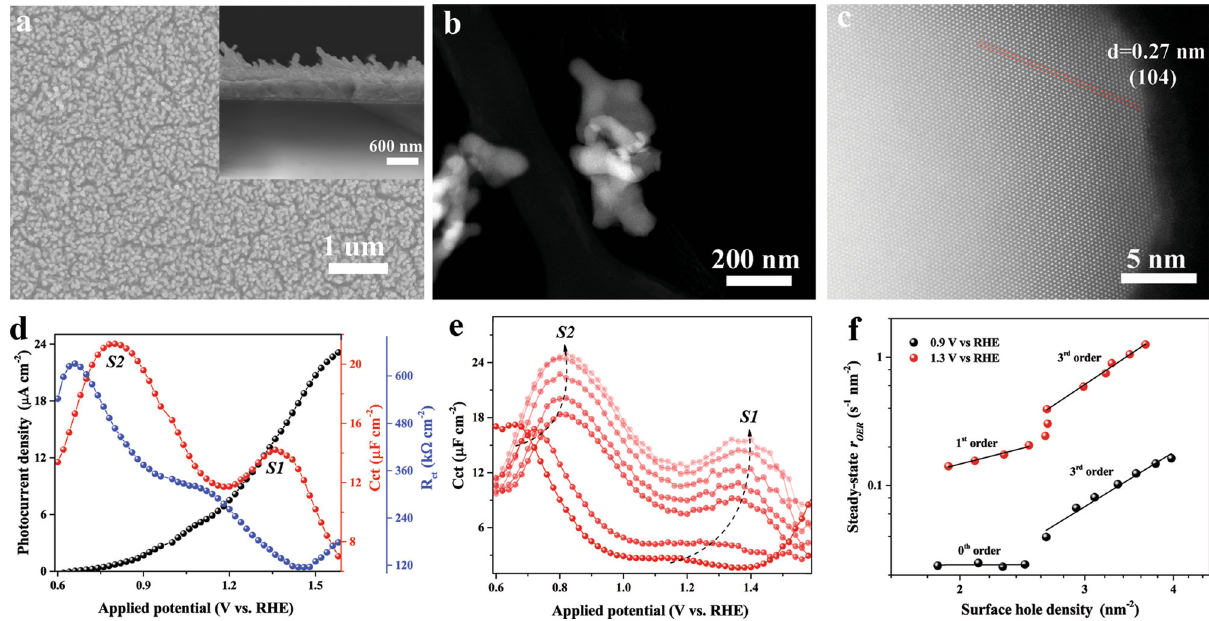
Fig. 1 Electron microscopic analyses of hematite photoanode and reaction kinetics of S1 and S2 at pH 8.0. a Representative top-view SEM image and cross-section (inset) of as-prepared hematite thin fi lm, b HAADF-STEM image of hematite nanorods, c magni fi ed image with atomic resolution, d J – V (black) and surface state capacitance ( C ct , red) and charge transfer resistance ( R ct , blue) evolution curves as a function of the applied potential (illumination intensity: 100 mWcm − 2 , pH 8.0), e evolution of surface state capacitance at stepwise-elevated illumination density (5, 8, 10, 20, 40, 60, and 80 mWcm − 2 , pH 8.0), the growth of S1 and S2 is indicated by arrows, f rate law analysis at 1.3 and 0.9 V vs. RHE (pH 8.0) where S1 and S2 reach their maximum values. Charge transfer capacitance and corresponding resistance R ct values were obtained by fi tting the measured data (Supplementary Fig. S5) with an equivalent circuit shown in Supplementary Fig. S6. Steady-state OER rate ( r OER ) and surface hole densities were probed by intensity- modulated